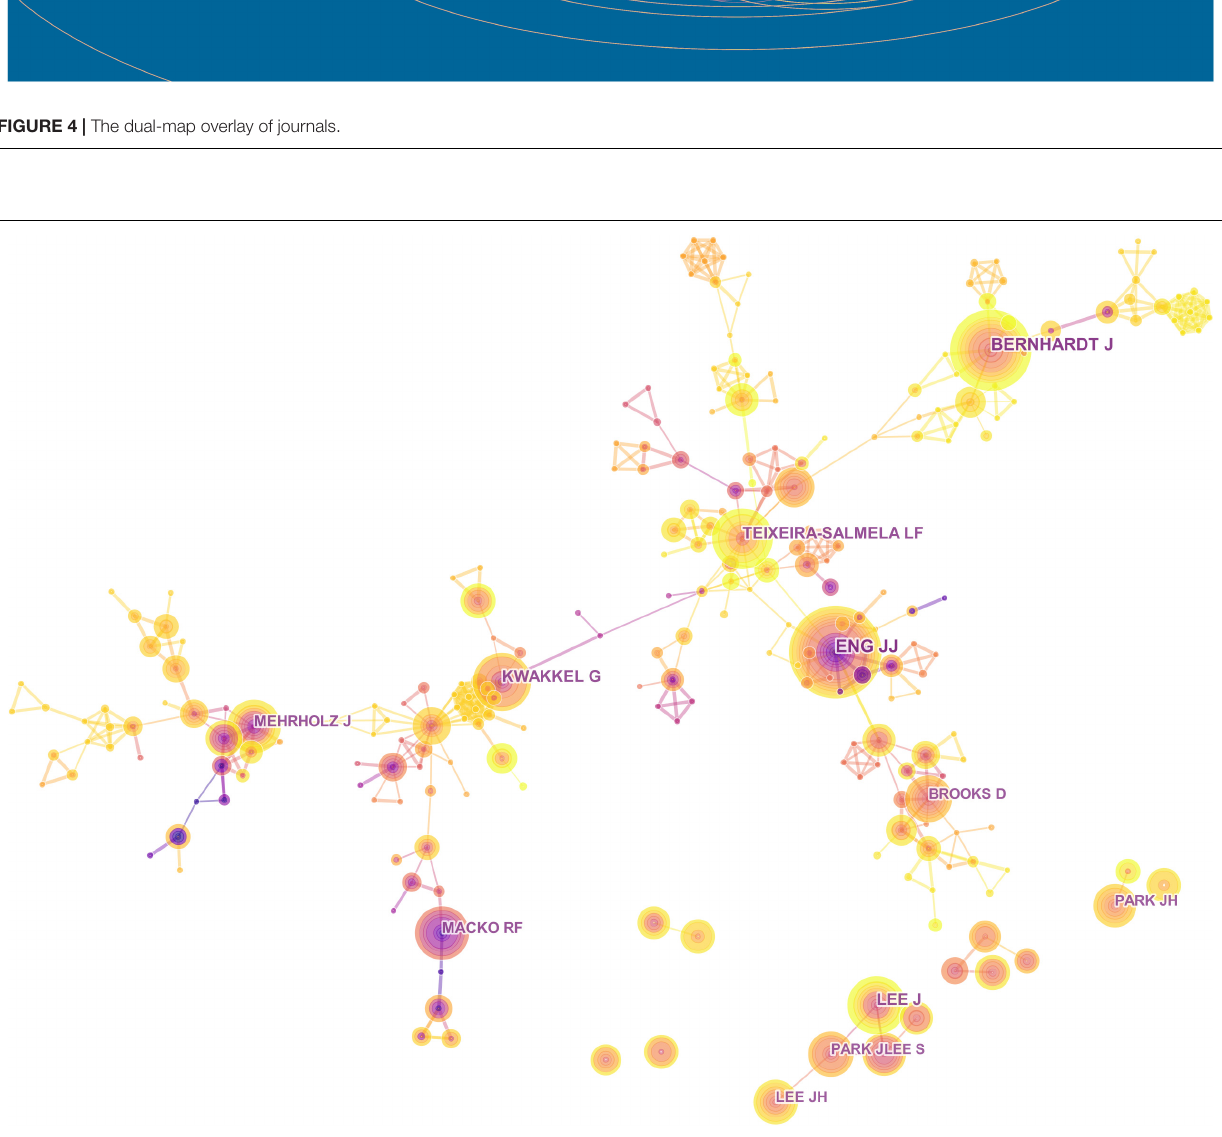
FIGURE 5 | Collaboration network of